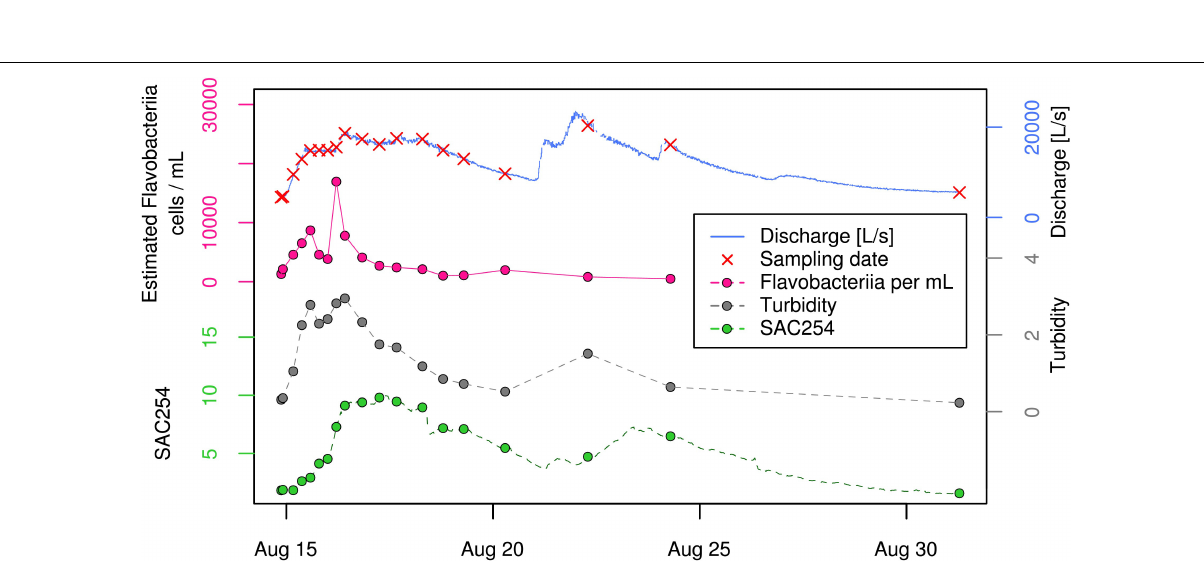
Frontiers in Microbiology |